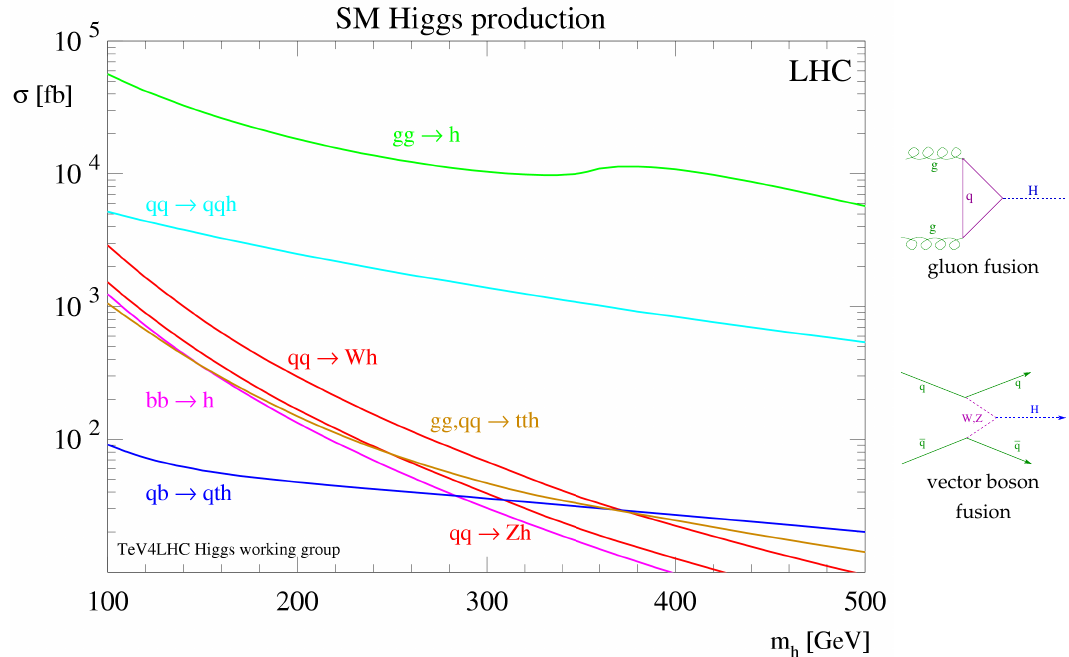
Figure 4. Predictions of the standard model for the production of the Higgs boson in proton-proton collisions [8]. The two most important formation channels are gluon fusion and vector boson fusion, and they were used to discover the Higgs boson. Later, all possible channels were observed and